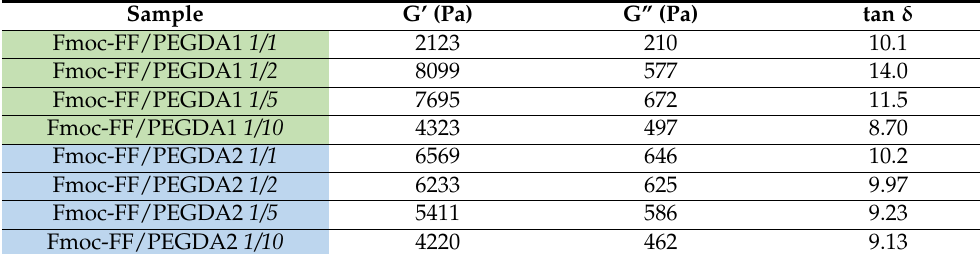
Table 3. Hydrogel rheological analysis. Reported data are storage modulus (G’), loss modulus (G”) and tan δ